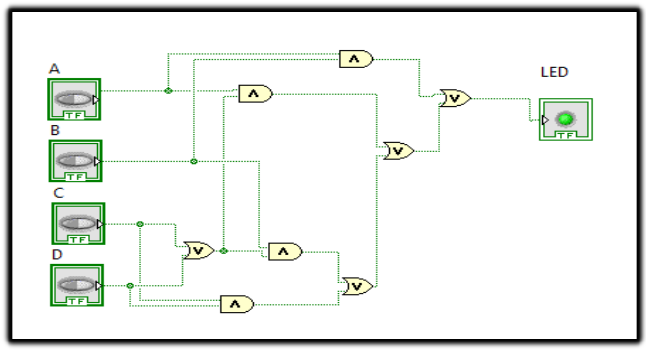
Fig. 5. 2 out of 4 voting logic design in LabVIEW